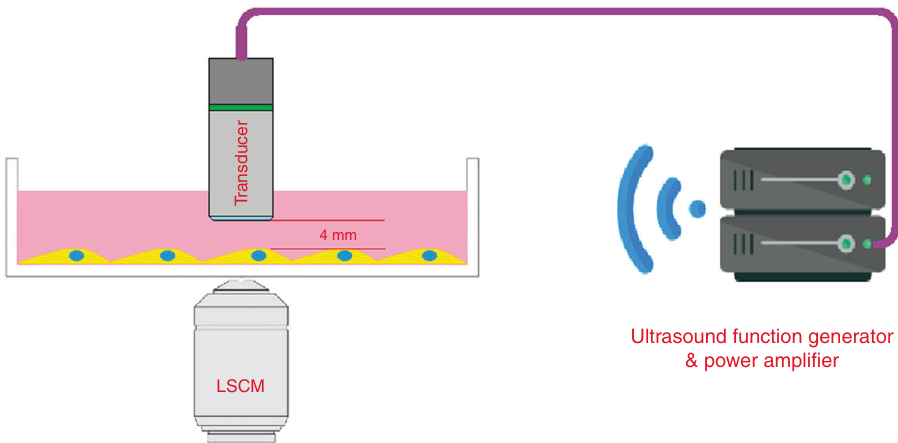
Fig. 6 Schematic diagram of the experimental setup for the LIPUS stimulation of MC3T3-E1 cells. The setup includes a function generator, a radio-frequency power ampli fi er, a transducer, and a laser scanning confocal microscope (LSCM). The surface of the transducer was immersed in the medium and located 4 mm away from the